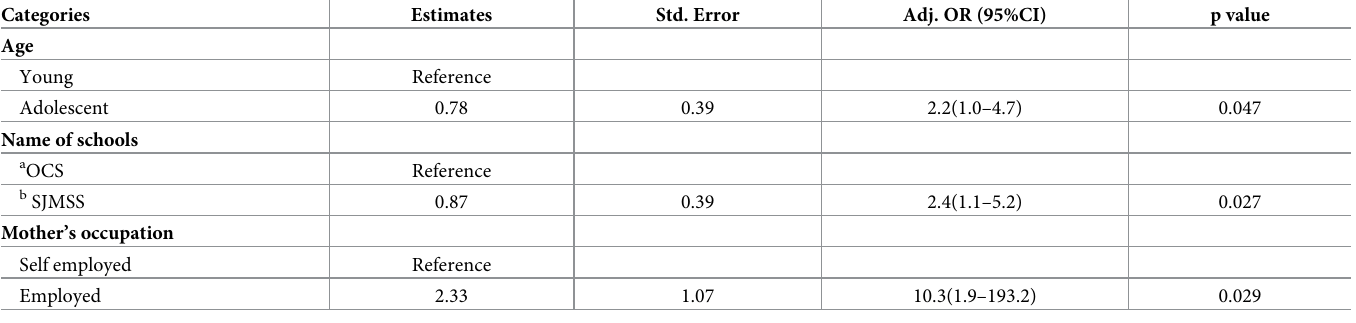
Table 3. Final multivariable logistic regression model to determine factors associated with baseline knowledge (pre-test questionaries) on rabies among the students (n = 129).